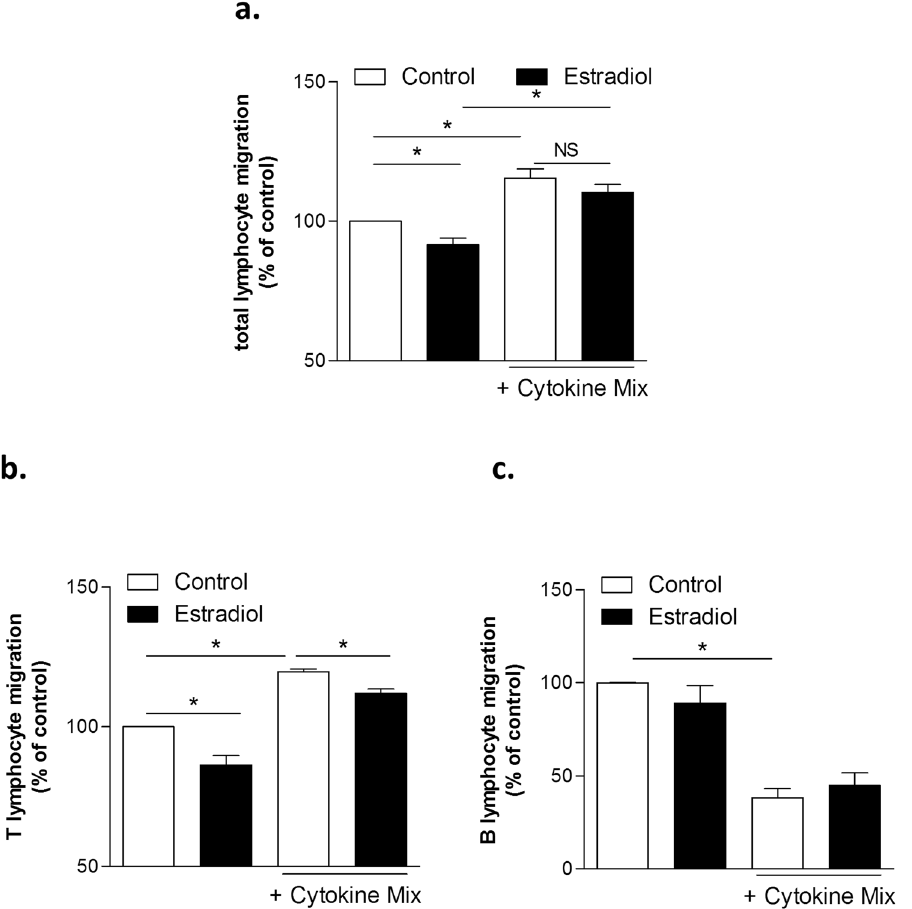
Figure 5. Analysis of Chemotactic properties of supernatants of human primary TECs treated with β -estradiol with or without a pro-inflammatory cytokine mix. Chemoattraction of PBL ( a ), T lymphocytes ( b ) and B lymphocytes ( c ) by supernatants of primary human TEC cultures treated with 17- β estradiol (10 − 8 M) with or without a mix of pro-inflammatory cytokines (IFN- γ , IL-1 β , and TNF- α ) for 24 hours. Results are expressed as the percentage of migrating cells through the well ( ± SEM). Each experiment was normalized to 100 for untreated cells. n = 4 to 6 different blood donors. P values were obtained using the Wilcoxon